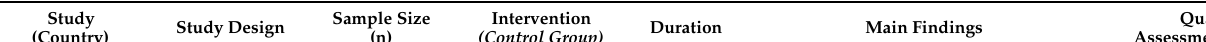
Table 2. Characteristics of included studies on omega-3 supplementation